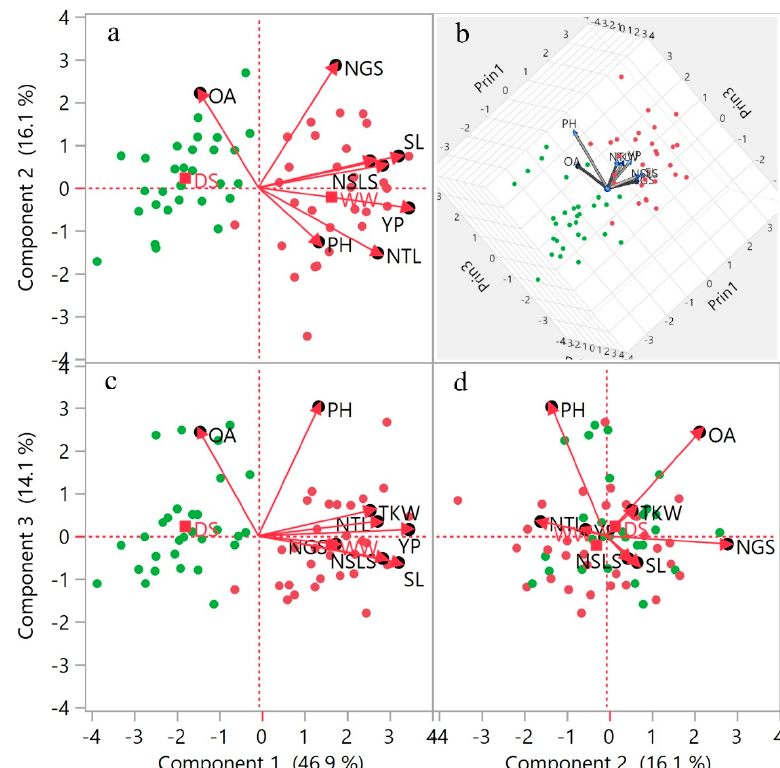
Figure 2. Biplot (Principal component analysis) for all traits assessed in wheat genotypes under well-watered (WW) and drought stress (DS) conditions. Scatter-plot shows the distribution of 30 wheat genotypes for OA, yield and yield components according to principal components 1 and 2 ( a ), components 1 and 3 ( c ), components 2 and 3 ( d ), and 3D scatter-plot of components 1, 2 and 3 ( b ). Here red dots represent genotypes under irrigation and green dots under stress conditions. For trait variables OA, osmotic adjustment; PH, plant height; NTL, number of tillers; SL, spike length; NSLS, number of spikelets per spike NGS, number of grains per spike; TKW, thousand kernel weight, and YP, yield per plant. Cubic Clustering Criterion is given in Supplementary Table S3.